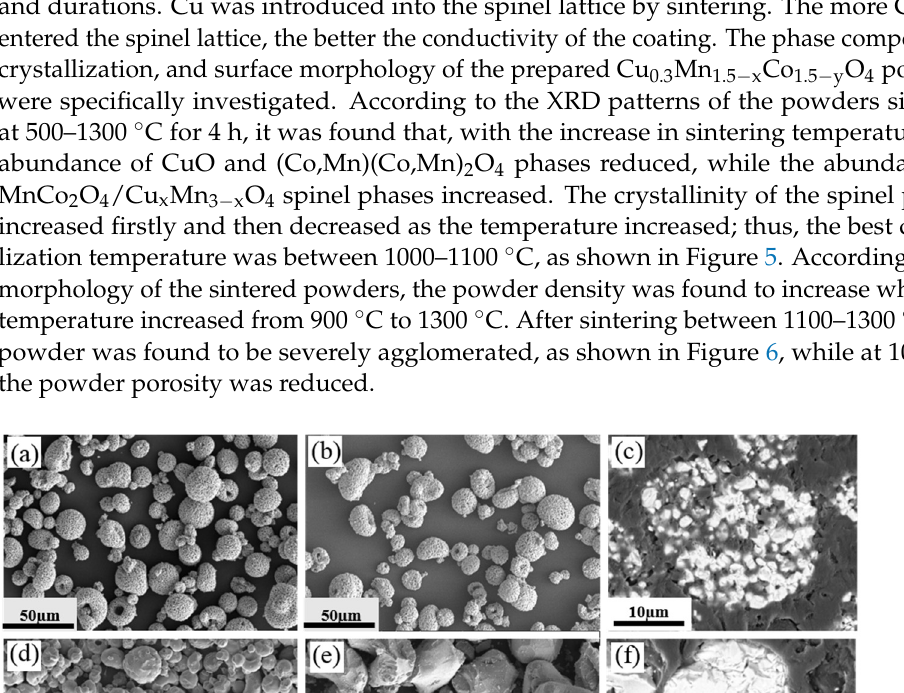
Figure 5. XRD patterns of doped powders sintered under different conditions: ( a ) and ( b ) 500–1300 °C for 4 h; ( c ) and ( d ) 1000 °C for 2–24 h.